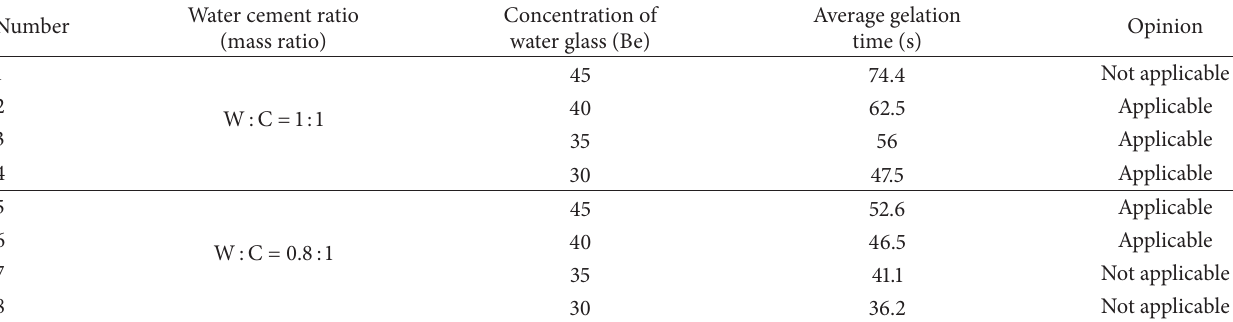
Table 1: Experiment results of grout with different mixture